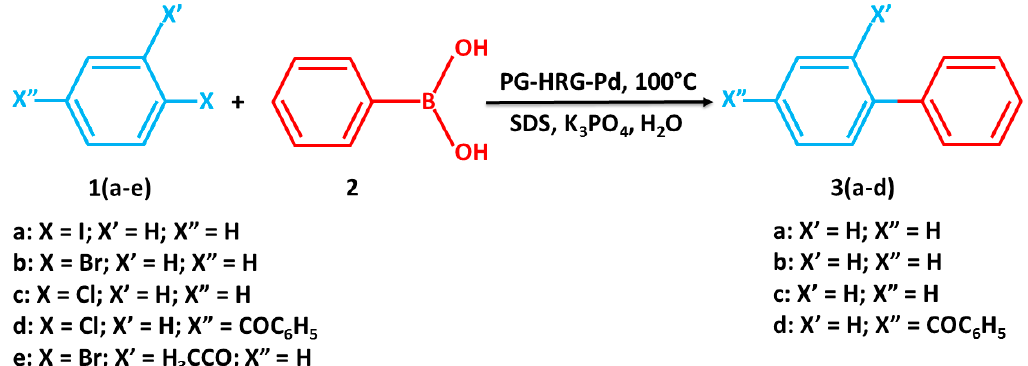
Figure 6. Schematic representation of the Suzuki reaction of iodobenzene, bromobenzene, and chlorobenzene, with phenylboronic acid under aqueous